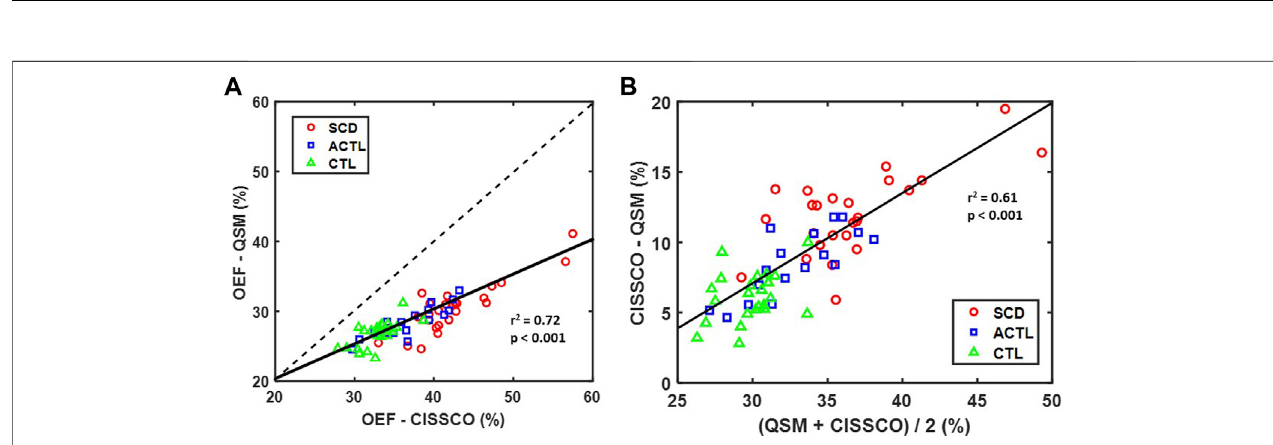
FIGURE 3| (A) Scatter plot of OEF-CISSCO and OEF-QSM with linear correlation line (solid) and identity line(dashed) ( r 2 = 0.72, p < 0.001). (B) Bland-Altman plot for OEF-CISSCO and OEF-QSM. The linear correlation line (solid) is shown ( r 2 = 0.61, p < 0.001).